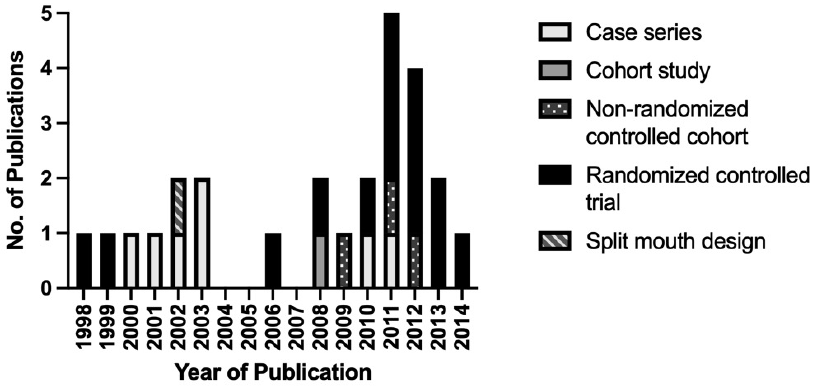
Table 5 . PRP indications investigated among top-cited clinical studies. Figure 7. Study design of clinical studies in the top 100 by year of publication.